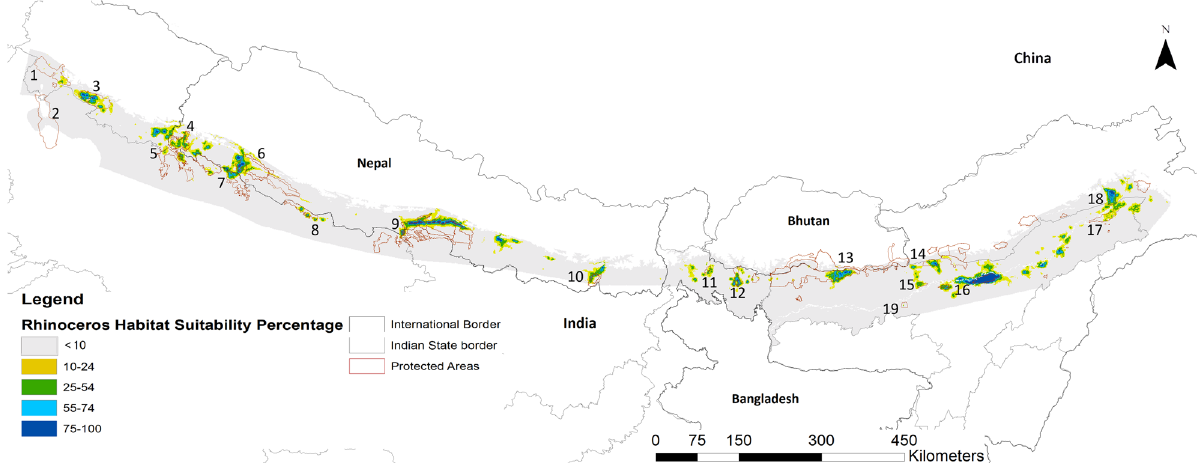
Figure 3. Distribution probability of greater one-horned Rhinoceros across its global historic range in the Terai-Brahmaputra floodplain, where 1-Rajaji NP, 2-Hastinapur WLS 3-Corbett NP, 4- Shukalaphanta NP, 5-Pilibhit TR, 6-Bardia, 7-Keterniyaghat WLS, 8- Sohelwa WLS, 9- Chitwan NP-Valmik TR-Parsa WLS Complex, 10-Koshi Tappu RAMSAR Site, 11- Gorumara WLS, 12- Jaldapara WLS, 13- Manas-Royal NP-Manas NP Complex, 14-Sonai Rupai WLS, 15- Orang TR, 16- Kaziranga NP, 17-Dibru Saikhowa WLS, 18- D’Ering Memorial WLS, 19- Pobitora WLS. Created in ESRI ArcMap 10.5.1 (https ://suppo rt.esri.com/en/Produ cts/Deskt